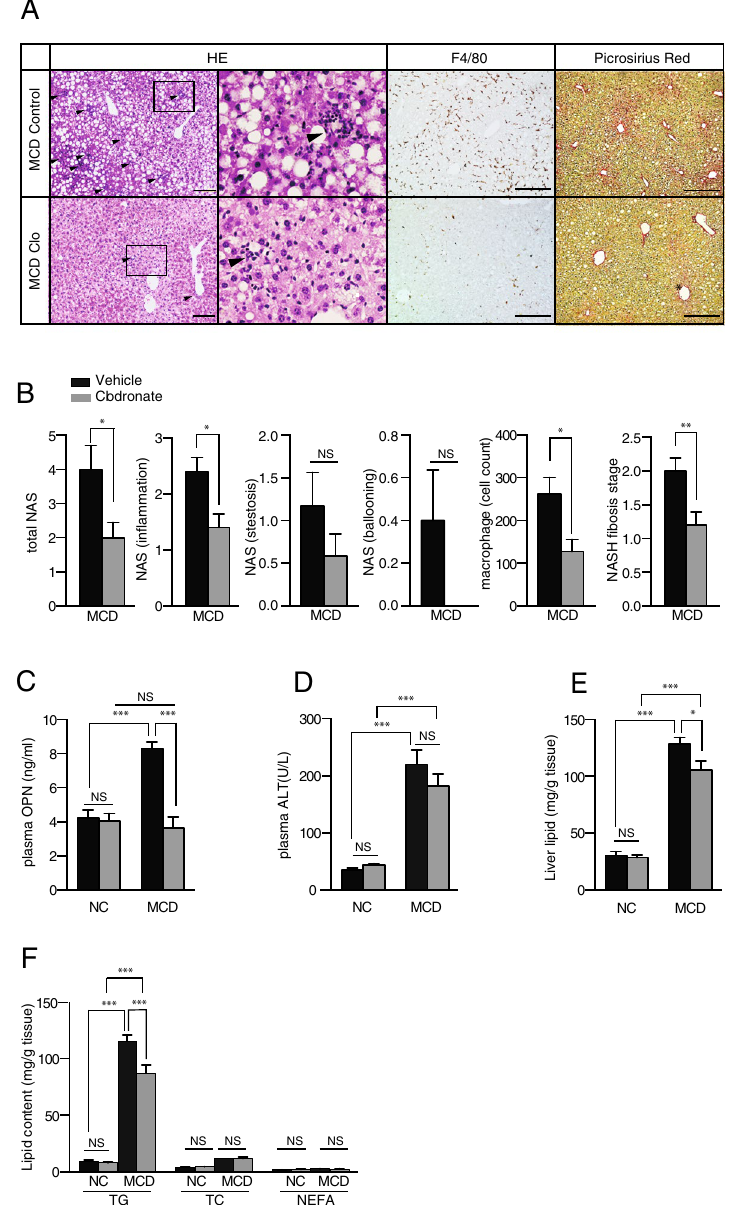
Figure 1. Pharmacologic inhibition of ATP signaling by clodronate protects against methionine- and choline- deficient diet-induced steatohepatitis. Ten-week-old C57BL/6 male mice were fed with normal chow (NC) or a methionine- and choline-deficient (MCD) diet for 4 weeks. The vehicle or 20 mg/kg body weight clodronate (Clo) was administered via daily subcutaneous injection for 4 weeks (n = 5–10 MCD diet-fed, per treatment; n = 3–5 NC-fed, per treatment). ( A ) Hematoxylin and eosin (HE) staining (arrowheads indicate inflammatory foci), F4/80 immunostaining, and Picrosirius Red staining of paraffin-embedded liver tissue from MCD diet-fed mice treated with the vehicle or clodronate. Scale bars, 100 µm. ( B ) The total NAFLD activity score (NAS); the individual scores for lobular inflammation, steatosis, and ballooning; the numbers of macrophages based on a count of the F4/80-positive cells per high-power field; and the NASH fibrosis stage were quantified in the MCD- fed groups. ( C ) The plasma osteopontin level was quantified with an enzyme-linked immunosorbent assay. ( D ) The plasma ALT activity was quantified. ( E ) The total hepatic lipid content was determined using Folch’s method. ( F ) The hepatic levels of triglycerides (TG), total cholesterol (TC), and nonesterified fatty acids (NEFA) were assessed with enzyme assays. All data are presented as the mean ± S.E.M. * P < 0.05, ** P < 0.01, *** P < 0.001. NS not significant, ALT alanine